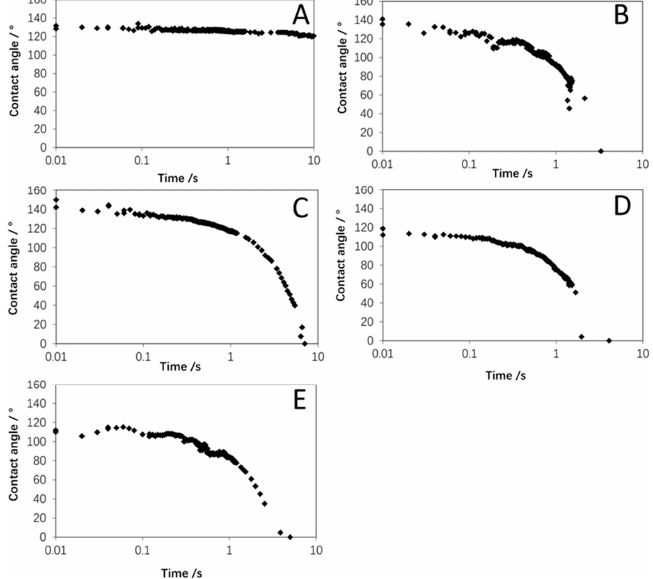
Figure 3. Contact angle data for original WPI powder ( A ), and agglomerated powders: ( B ) 0% WPI; ( C ) 10% WPI; ( D ) 20% WPI; ( E ) 30% WPI.